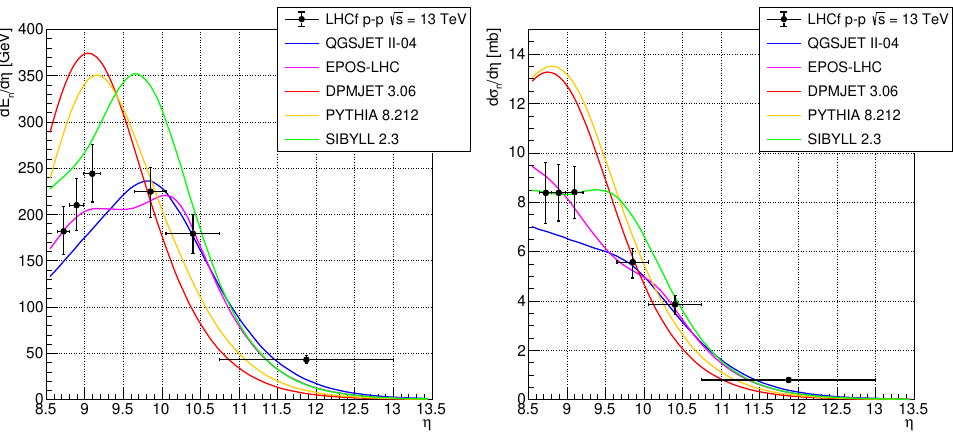
Figure 3 . Di(cid:11)erential energy (cid:13)ow d E n = d (cid:17) (left) and di(cid:11)erential cross section d (cid:27) n = d (cid:17) (right) p of neutrons produced in p-p collisions at s = 13 TeV, measured using the LHCf Arm2 detector. Black markers represent the experimental data with statistical and systematic uncertainties, whereas colored lines refer to model predictions at the generator level.